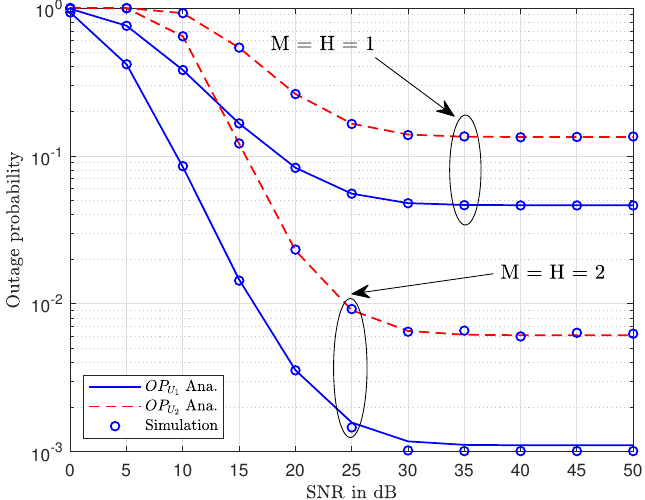
Figure 9. Outage probability of U 1 and U 1 vs. number of antenna M = H